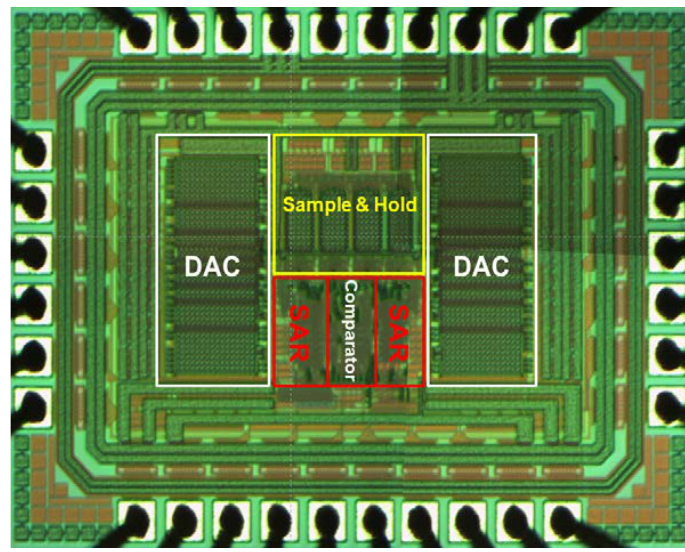
Figure 13. Post-layout-simulated PSD of the proposed SAR ADC.